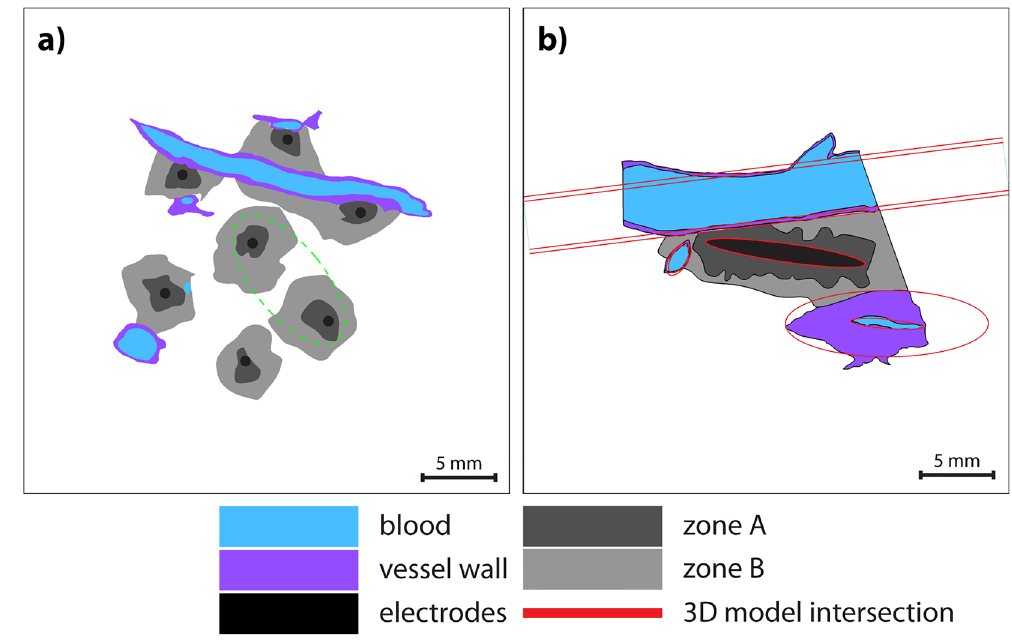
Figure 5. Numerical model geometries. ( a ) 2D model geometry of sample S1 is constructed directly from the outlined microscopic image. Green circle indicates the section of the model, used in the parametric study of septa electrical conductivity. ( b ) A slice from the simplified 3D model with linear electrodes. The location of the slice corresponds to the microscopic image of sample S3. Intersections of the geometric entities with the outlined microscopic image are shown in